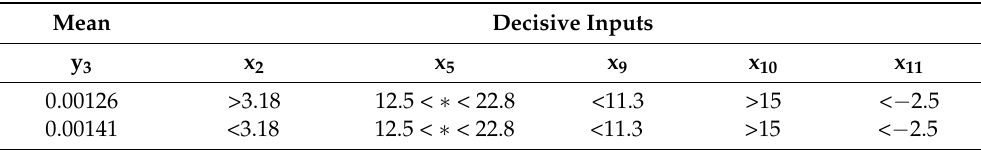
Table 4. The most decisive inputs and their optimal values for the favorable y 3 (cm 2 /K min) value corresponding to the Voronkov criteria, derived from RT analysis. The data ranges correspond to the white nodes in Figure 7.